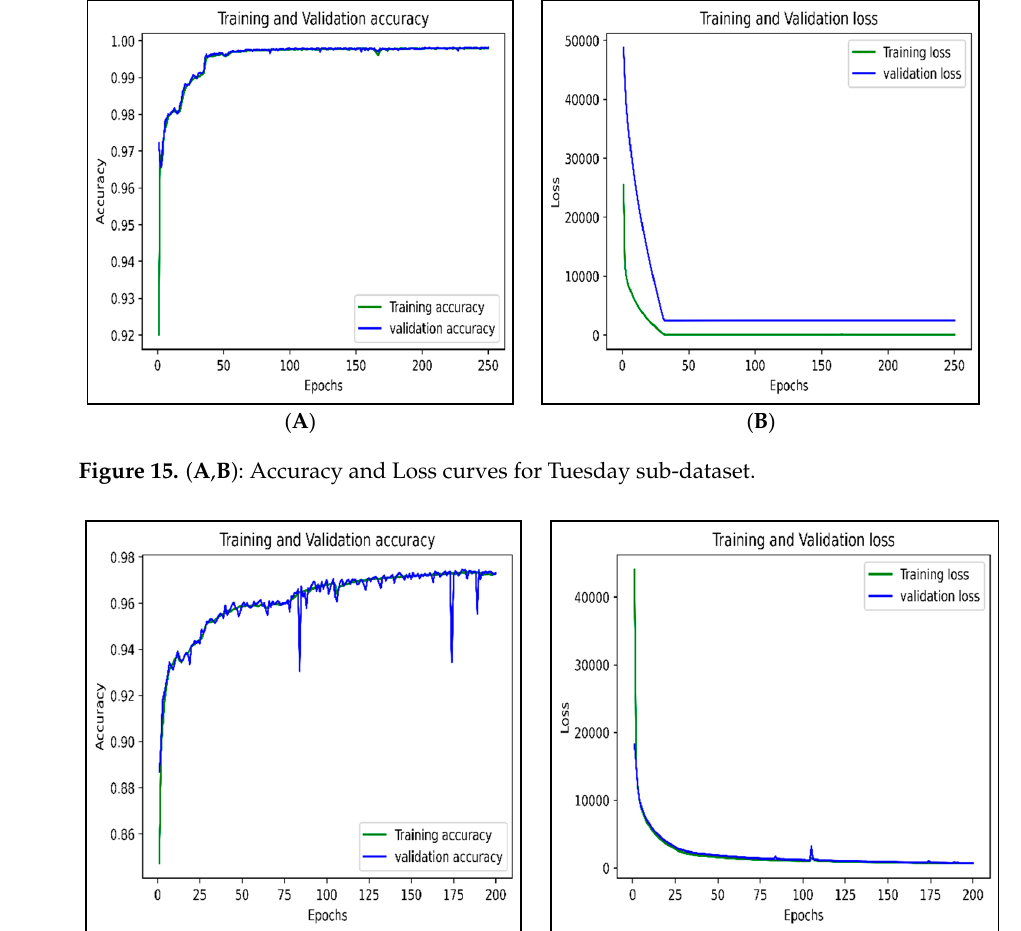
( B ) Figure 17. ( A,B ): Accuracy and Loss curves for Thursday morning sub-dataset. ( A ) ( B ) Figure 18. ( A,B ): Accuracy and Loss curves for Thursday afternoon sub-dataset.